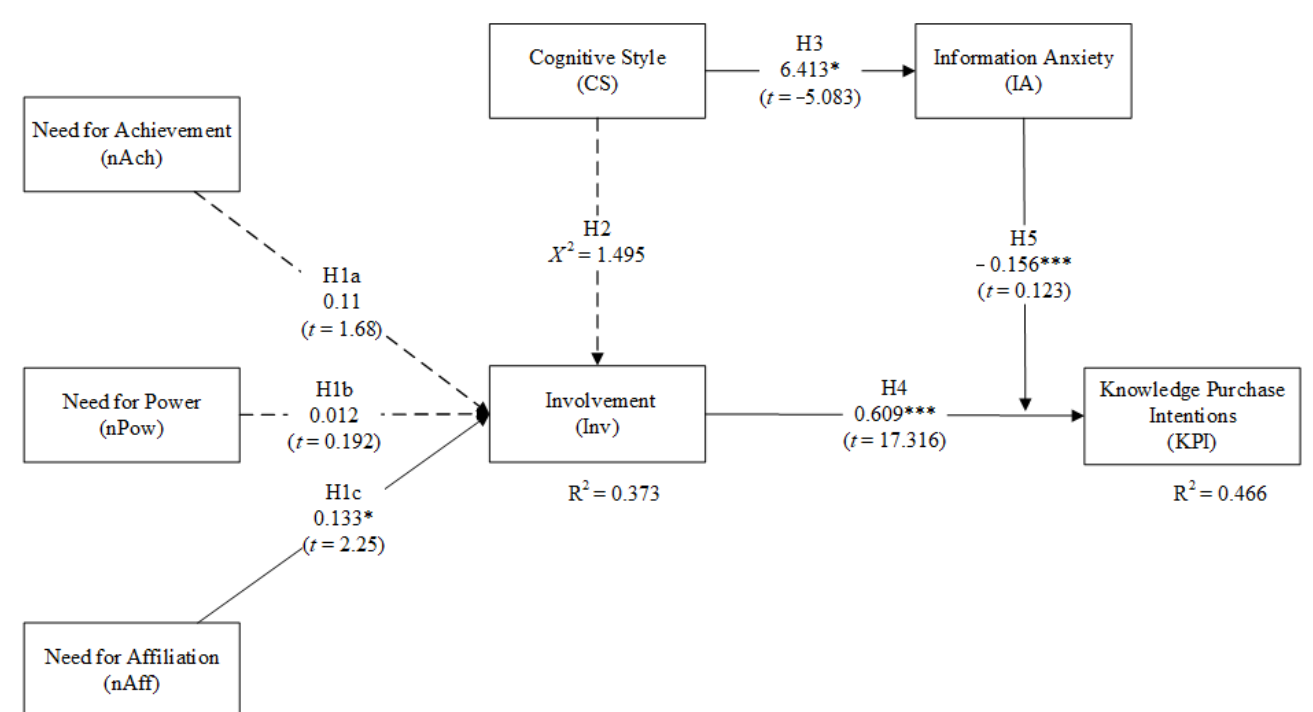
Figure 3. The test results of the research model. Note: * p < 0.05, *** p < 0.001. R 2 refers to determination coefficient; χ 2 refers to distribution coefficient; t value refers to coefficient of Student’s t -test.